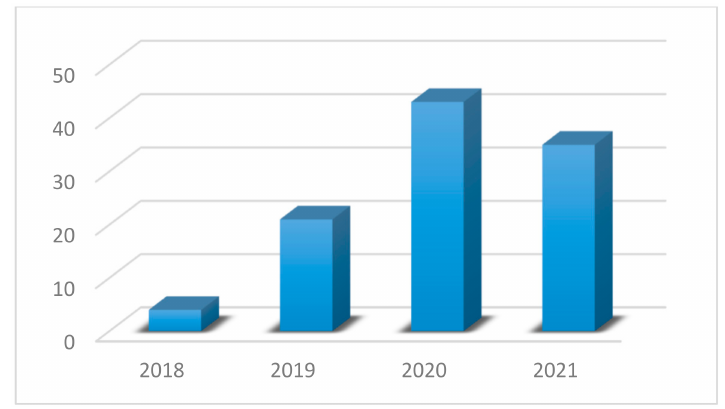
Figure 3. Papers per year from app dimensions